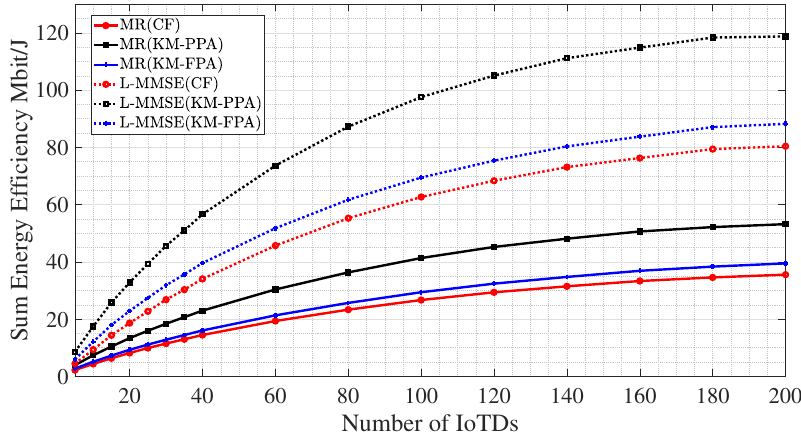
Figure 7. The sum energy efficiency versus the number of IoTDs; APs equipped with multiple antennas.